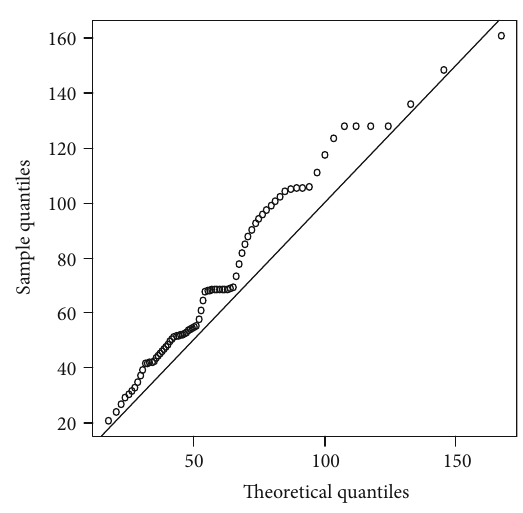
Figure 5: The quantile plot of the bearing balls data.